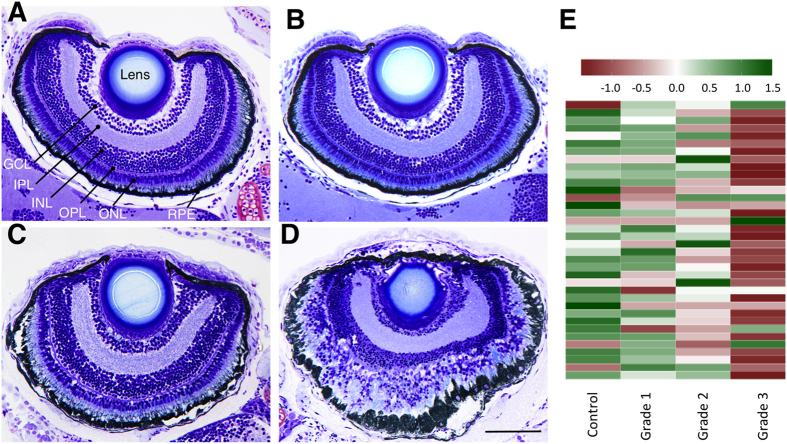
CPO induces concentration-dependent impairment of the retina architecture and the phototransduction pathways in zebrafish larvae.Retinal histology (transverse plastic semithin sections) of representative control (A), grade 1 (B) grade 2 (C) and grade 3 (D) 8 days post fertilization zebrafish larvae shows a good relationship between the grade of the phenotype and the severity of the effects on the retinal architecture. (E) Heatmap of the phototransduction pathway (dre04744) in zebrafish control and grades 1, 2 and 3 larvae, showing a clear relationship between the grade of phenotype severity and the degree of down-regulation of this pathway. Abbreviations: GCL, ganglion cell layer; INL, inner nuclear layer; IPL, inner plexiform layer; ONL, outer nuclear layer; OPL; outer plexiform layer; RPE, retinal pigment epithelium. Scale bar: 100 μm.